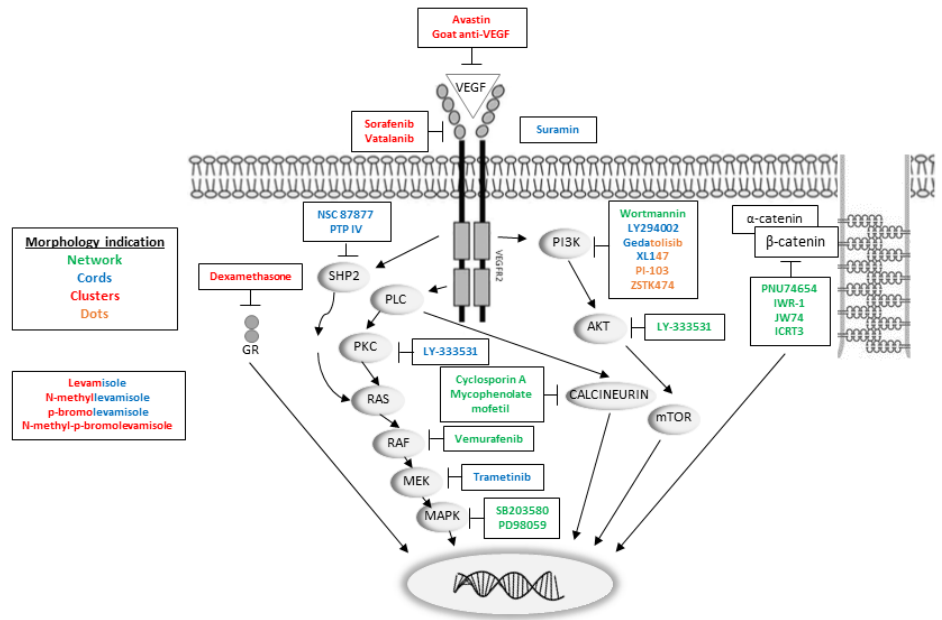
Figure 6. VEGFR2 downstream pathway with insertion of some of the inhibitor targets, with the HUVEC morphology indicated by colors. Green: network, blue: cords, red: clusters, orange: dots. Two colors indicate mixed morphology. The exact mechanism of action of suramin is still unknown, but it can bind to VEGF and VEGFR2’s co-receptor neuropilin, (not shown in the figure). From left to right: the SHP2-RAS-RAF-MEK-MAPK pathway, the PLC-PKC-RAS-RAF-MEK-MAPK pathway, the PLC-calcineurin pathway and the PI3K-AKT-mTOR pathway, which results in activation of key transcription factors and prepares the cell for differentiation and/or proliferation. Activation of PLC results in the hydrolysis of PIP2 and leads to generation of DAG and IP3. DAG is an activator of PKC, which among others activates the MAPK signaling pathway, including RAS, the serine/threonine protein kinase RAF and MEK. The RAS-RAF-MEK-MAPK pathway can also be activated by SHP2, which is coupled to VEGFR2 through Gab1. Another action of PLC is activation of calcineurin, a